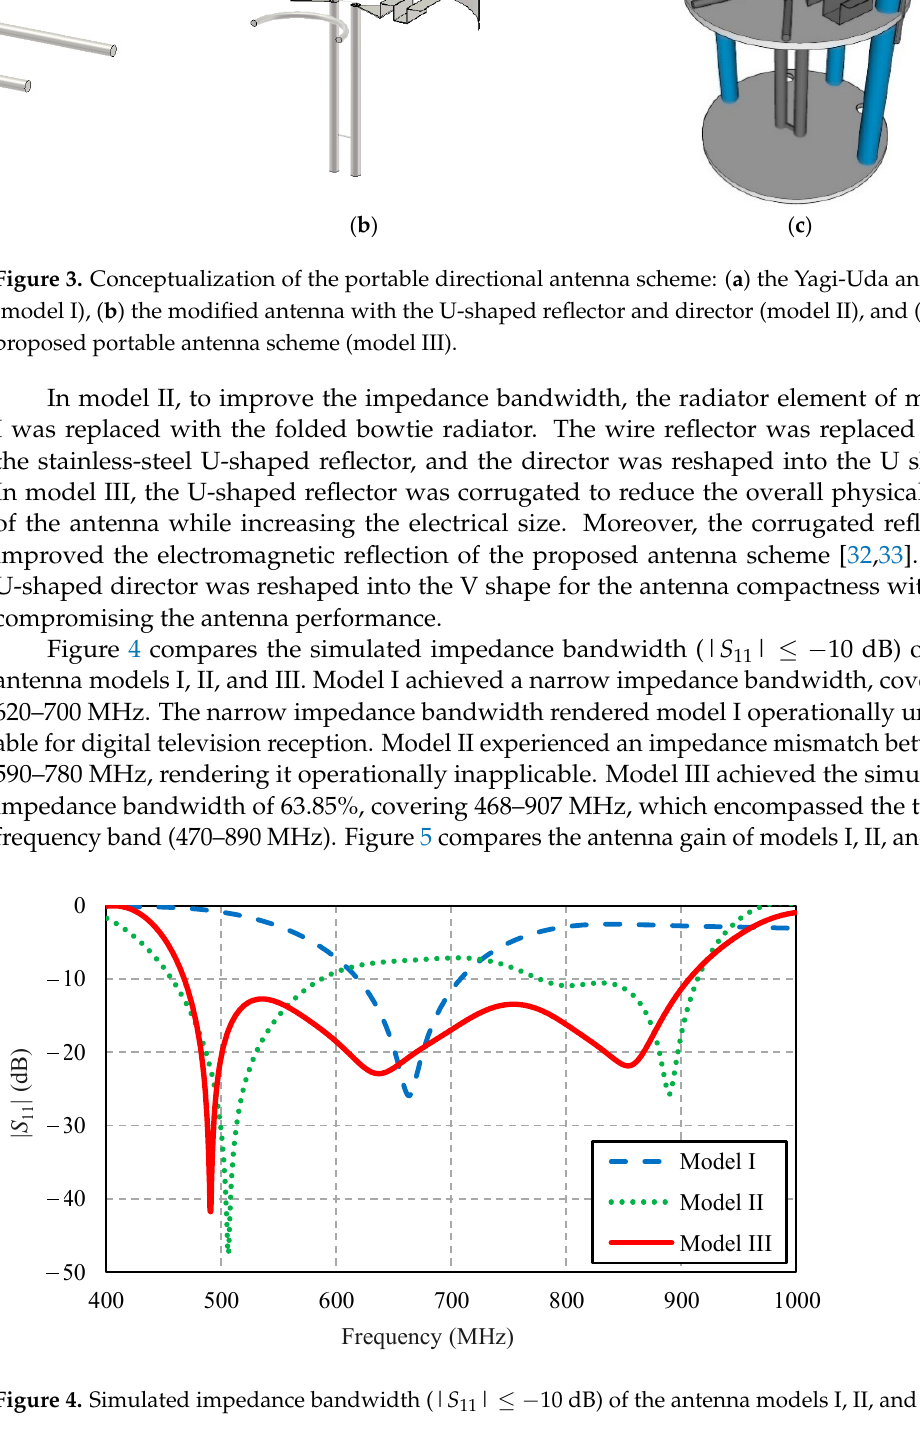
Figure 3. Conceptualization of the portable directional antenna scheme: ( a ) the Yagi-Uda antenna (model I), ( b ) the modified antenna with the U-shaped reflector and director (model II), and ( c ) the proposed portable antenna scheme (model III).